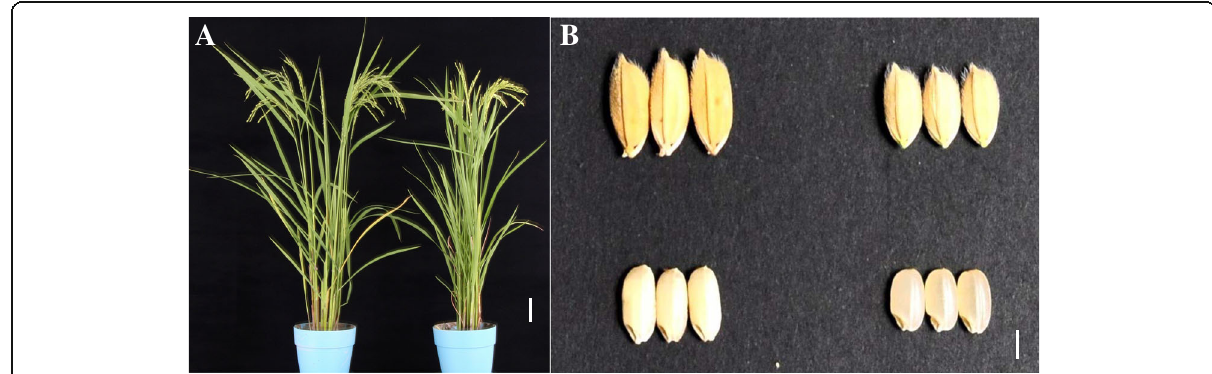
Fig. 1 Comparison of whole-plant rice and grain performance between IL188 and Nipponbare. A, Plant type of IL188 (left) and Nipponbare (right). B, Paddy and brown rice grains of IL188 (left) and Nipponbare (right). Bars: 10 cm in A, 6 mm in